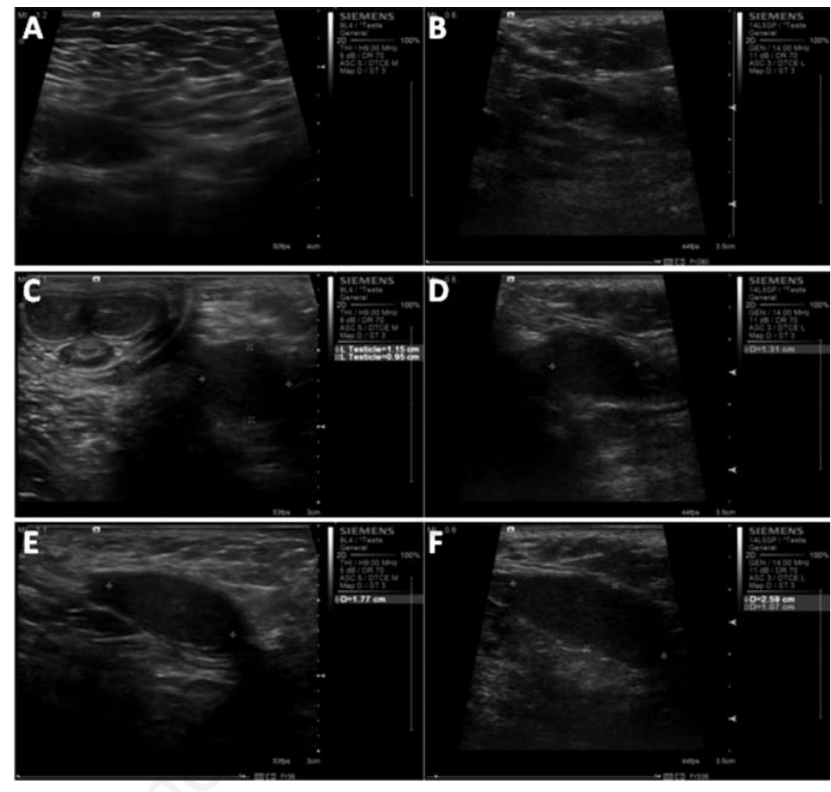
Figure 1. Ultrasound comparison of the scrotum demonstrating improvement in scar for- mation between the first and second round of treatment. A-B: transverse images of the scrotum. (A) Ultrasound before second round of treatment showing a thickened scrotal wall with complex echogenicity. (B) Ultrasound after the second round of treatment showing improvement in the scrotal wall and echogenicity. C-D: Transverse ultrasound images of the left testicle. (C) Image from before second round of treatment showing tes- ticle located in the inguinal canal, surrounded by scar tissue with complex echonicity. (D) Image from after the second round of treatment showing the testicle located farther down in the inguinal canal with less scar tissue demonstrating complex echonicity surrounding the testicle. E-F: Longitudinal ultrasound images of the left testicle. The surrounding tis- sue of the testicle after treatment (E) is decreased in complexity as compared to before the second round of treatment (F).